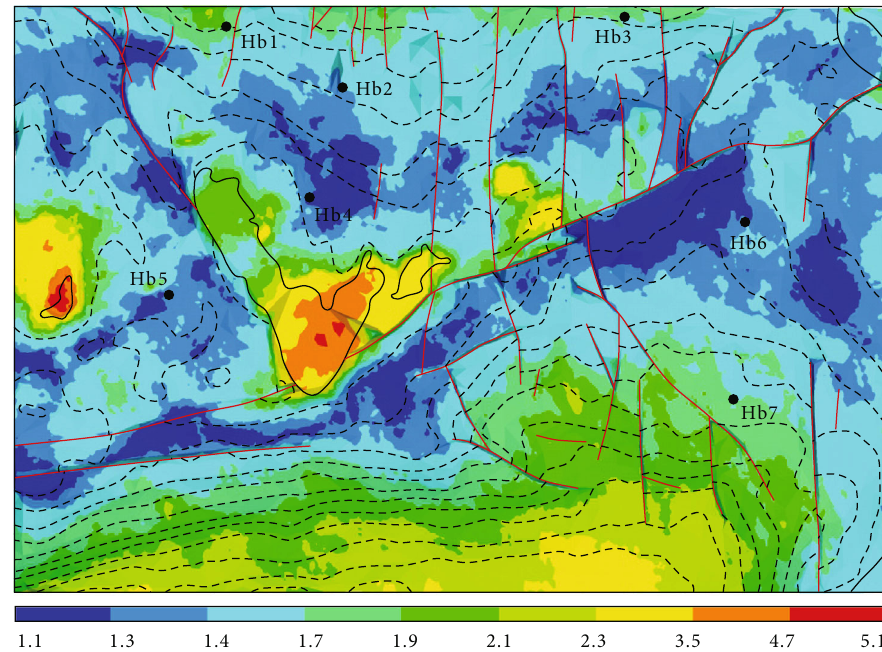
Figure 10: Distribution of the unequilibrium tectonic indicator ( K ) in the Longmaxi Formation of Haiba Block.